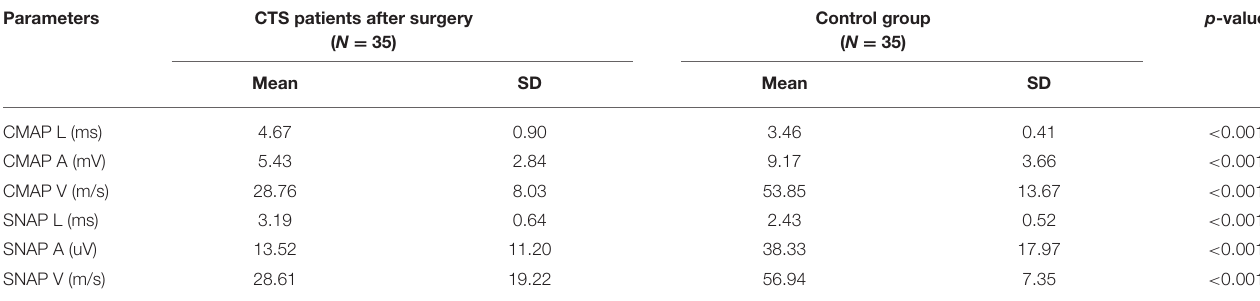
TABLE 1B | Comparison of standard motor and sensory parameters in CTS patients after the surgery and in the control group. Parameters CTS patients after surgery ( N =